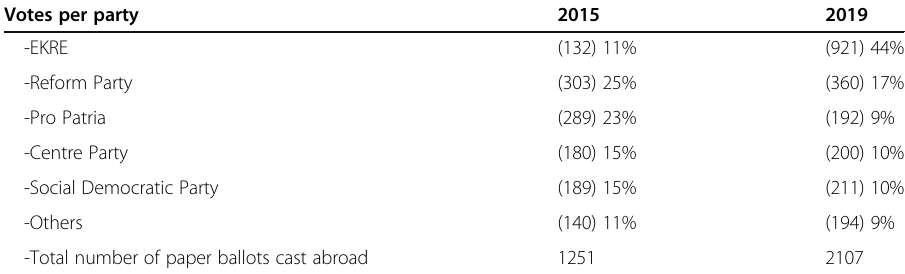
Table 1 External voting results (postal voting and embassy voting combined) at 2015 and 2019 Estonian general